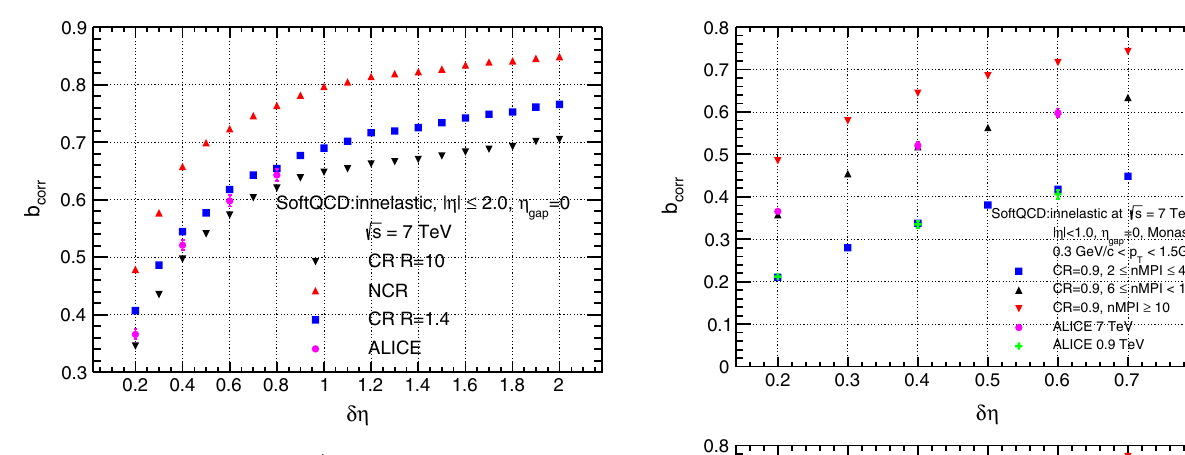
Fig. 7 b Corr for p + p collisions at of CR and without it